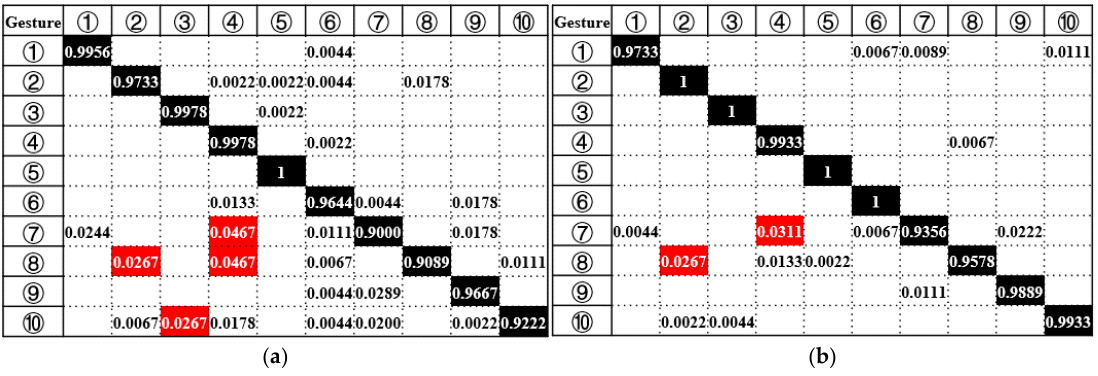
Figure 10. ( a ) Confusion matrix of gesture recognition in sitting conditions; ( b ) Confusion matrix of gesture recognition in standing conditions.